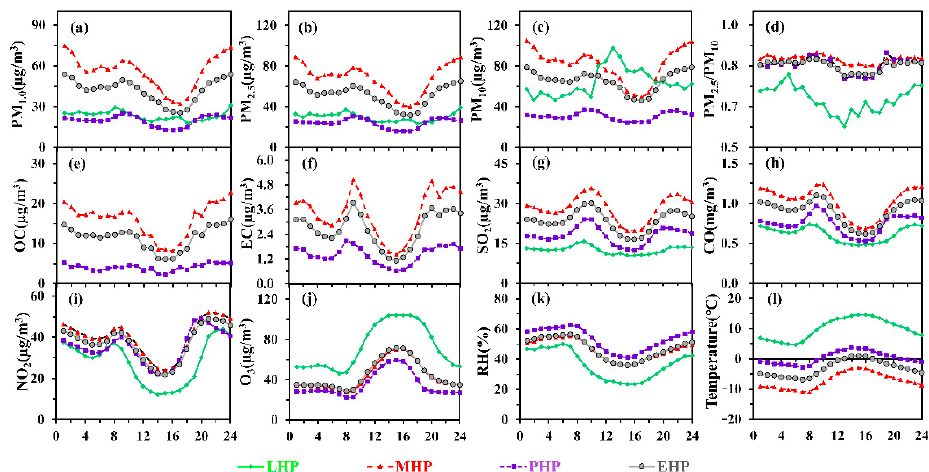
Figure 3. Diurnal variation of pollutants concentration of (( a ): PM 1.0 , ( b ): PM 2.5 , ( c ): PM 10 , ( d ): PM 2.5 /PM 10 , ( e ): OC, ( f ): EC, ( g ): SO 2 , ( h ): CO, ( i ): NO 2 and ( j ): O 3 ) and meteorological elements (( k ): relative humidity, and ( l ) ambient temperature) observed during EHP, PHP, MHP and LHP, respectively.